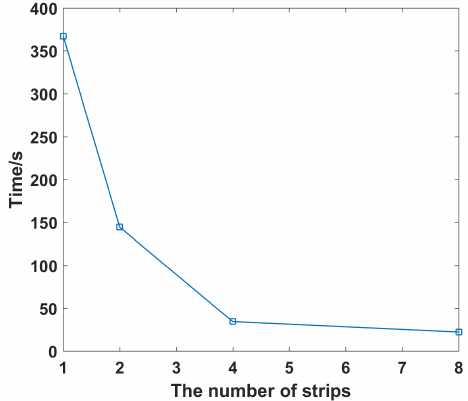
Figure 8. Imaging time under different number of